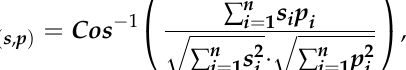
Table 1 is an example of a relative Rayleigh scattering model applied to an artificial sensor with visible and near infrared wavelengths ( λ ) to create a diffuse skylight vector using Equation (2). Table 1. Relative Rayleigh scattering model ( λ − 4 ) applied to visible and NIR wavelengths. Percentage of total scatter is used to create a diffuse skylight vector. A worked example is the Green wavelength where 1.22 − 4 = 0.448 resulting in 0.448/1.756 = 0.26 (or 26%).